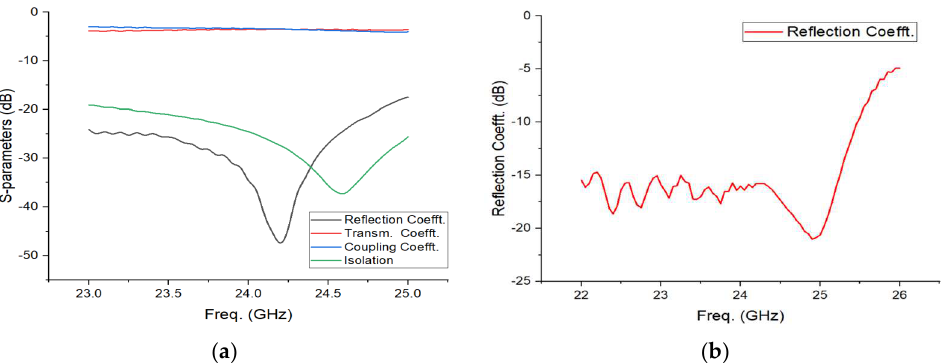
Figure 10. Configuration of the circular polarizer using a Branch-line coupler.